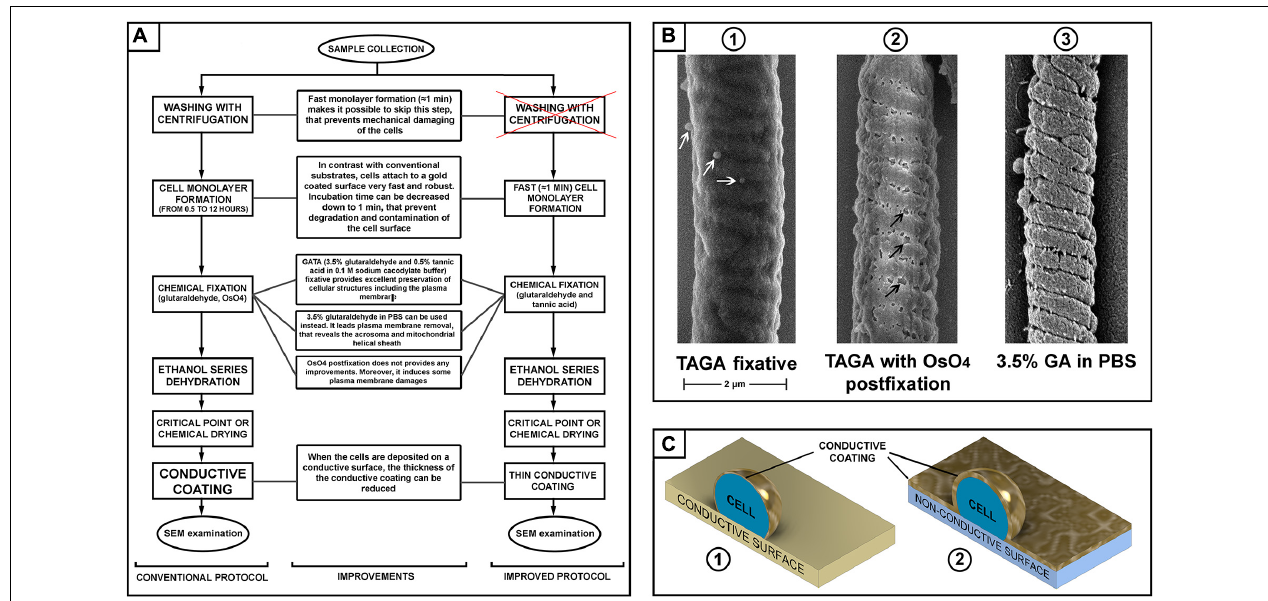
FIGURE 1 | (A) Scheme of sperm preparation for scanning electron microscopy (SEM) examination–conventional and improved protocols. (B) SEM pictures of a mouse sperm mid-piece with different fixation: glutaraldehyde and tannic acid [(B1) microvesicles are indicated with white arrows]; glutaraldehyde then post-fixation with osmium tetroxide [(B2) plasma membrane damage is indicated with black arrows]; and fixed with glutaraldehyde in PBS [(B3), removal of the plasma membrane revealing the helically arranged mitochondria sheath], scale bar 2 µ m. (C) A schematic illustration of the advantage of a conductive substrate (C1) for SEM sample preparation–the conductive coating of the cells can be thinner than it should be for a non-conductive substrate